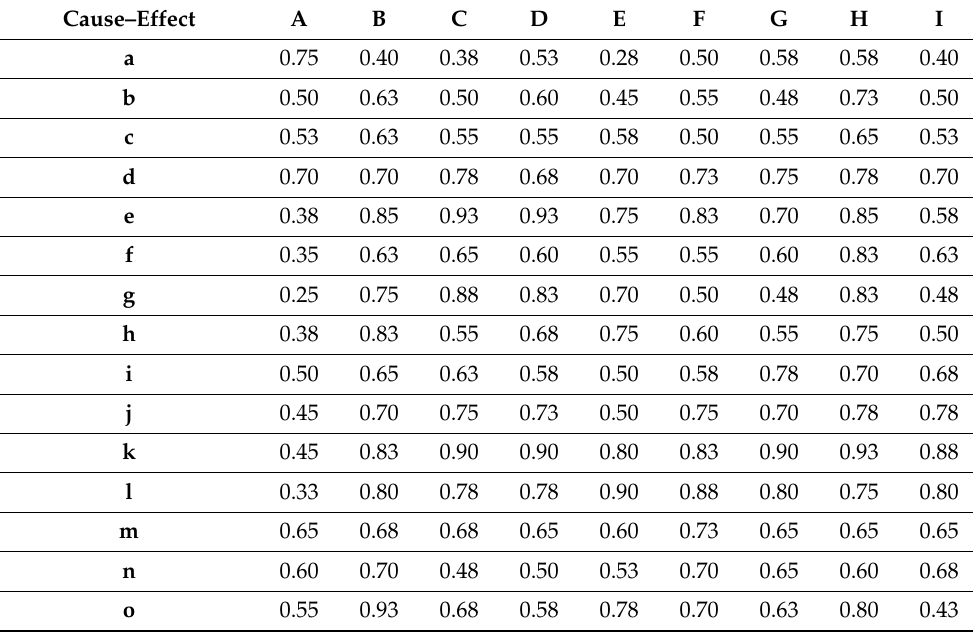
Table 4. Expertons made up of the cause–effect valuation carried out by the group of experts from the tourism sector (Matrix